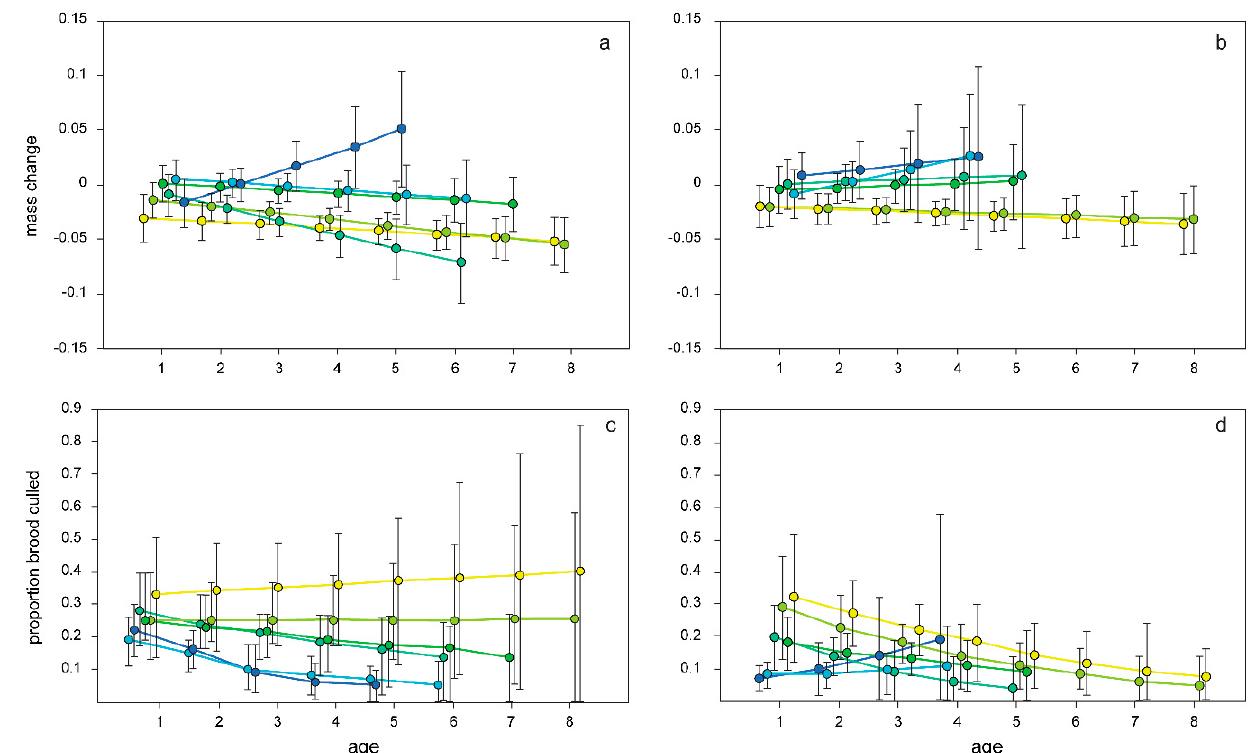
Figure 3. ( a ) Mean mass change (in grams, error bars are 95% confidence intervals, same on all panels) of female N. marginatus during reproduction on six carcass sizes (5 g = yellow, 10 g = yellow/green, 20 g = green, 30 g = blue/green, 40 g = light blue, 50 g = dark blue; same on all panels) by reproductive bout as age. ( b ) Mean mass change of female N. guttula during reproduction on six carcass sizes by reproductive bout as age. ( c ) Mean proportion of the brood culled by female N. marginatus on six carcass sizes by reproductive bout as age. ( d ) Mean proportion of the brood culled by female N. guttula on six carcass sizes by reproductive bout as